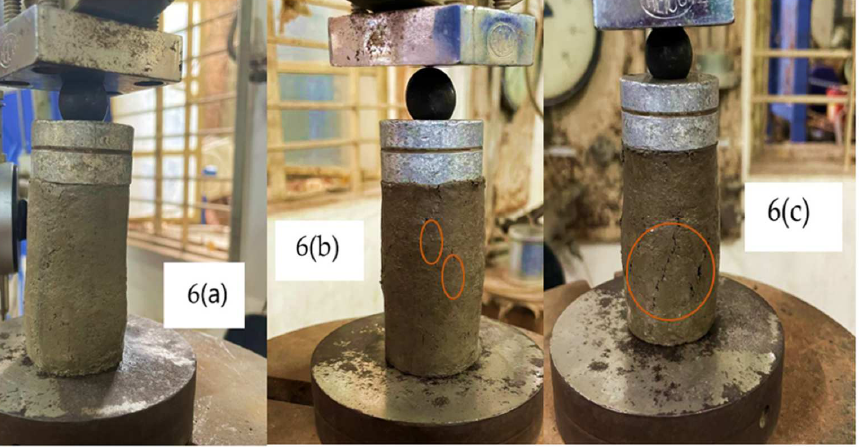
Figure 6. Failure response of ( a ) M1 ( b ) M2 ( c ) M3 samples mixed with 1.5% CLS.